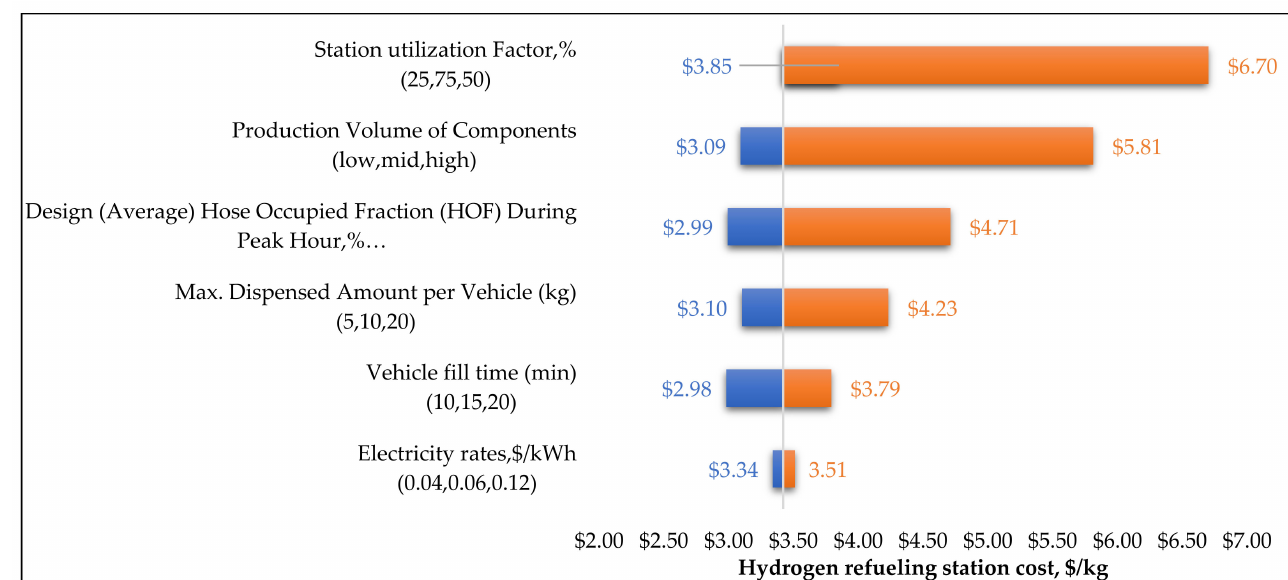
Figure 17. Range of refueling costs for a station receiving hydrogen through gaseous tube